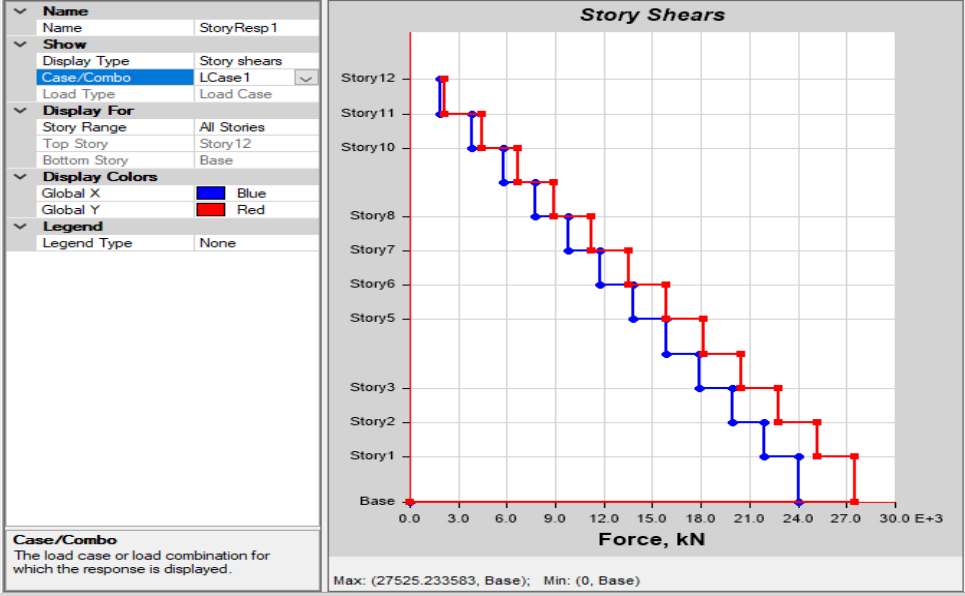
Figure 11. Maximum story shear.